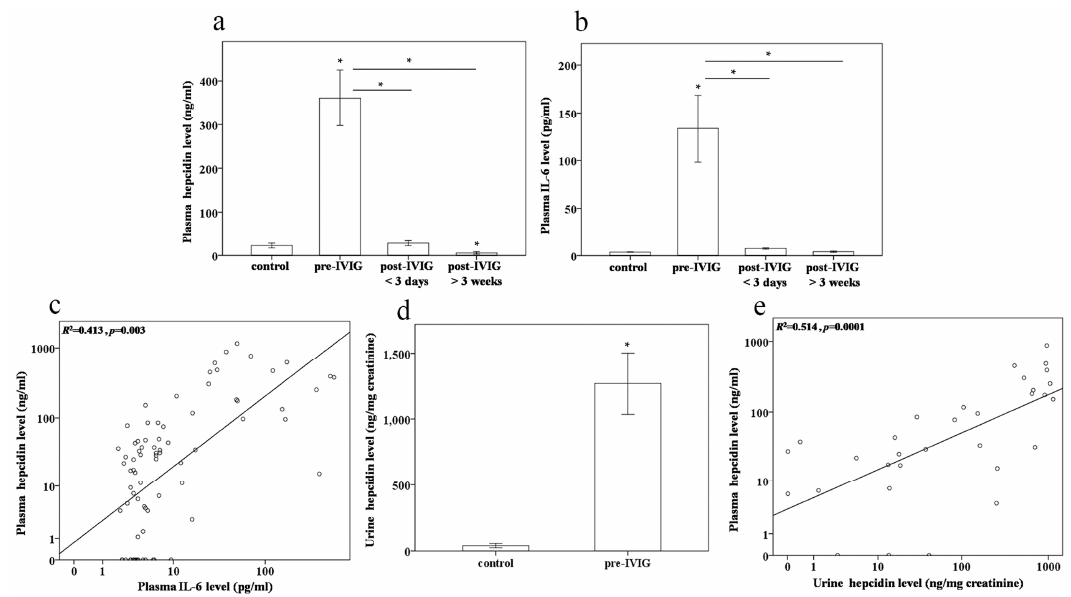
Figure 3. Comparison of plasma ( a ) hepcidin, ( b ) IL-6, and ( d ) urine hepcidin levels in patients with Kawasaki disease (KD) ( N = 20) before and after undergoing intravenous immunoglobulin (IVIG) treatment; ( c ) Univariate analysis demonstrated that the log plasma hepcidin levels were positively and significantly correlated with the log IL-6 levels in patients with KD and the controls ( R 2 = 0.413, p = 0.003); ( e ) Univariate analysis demonstrated that the log plasma hepcidin levels were positively and significantly correlated with the log urine hepcidin levels in the KD before IVIG treatment and control groups ( R 2 = 0.514, p = 0.0001). Data are presented as mean ± standard error. * indicates p < 0.05 between the control and KD groups.